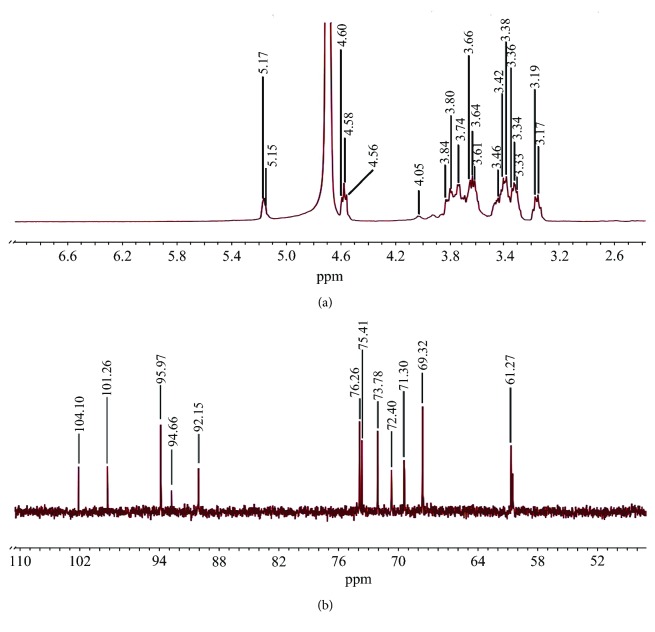
NMR analysis: 1H NMR (a); 13C NMR (b).